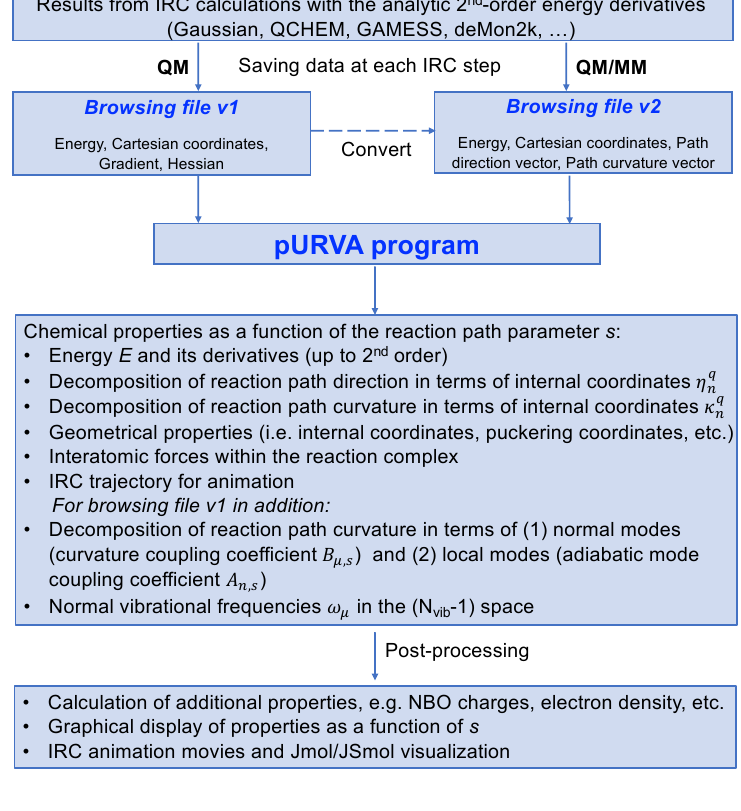
Figure A1. Flowchart of the pURVA